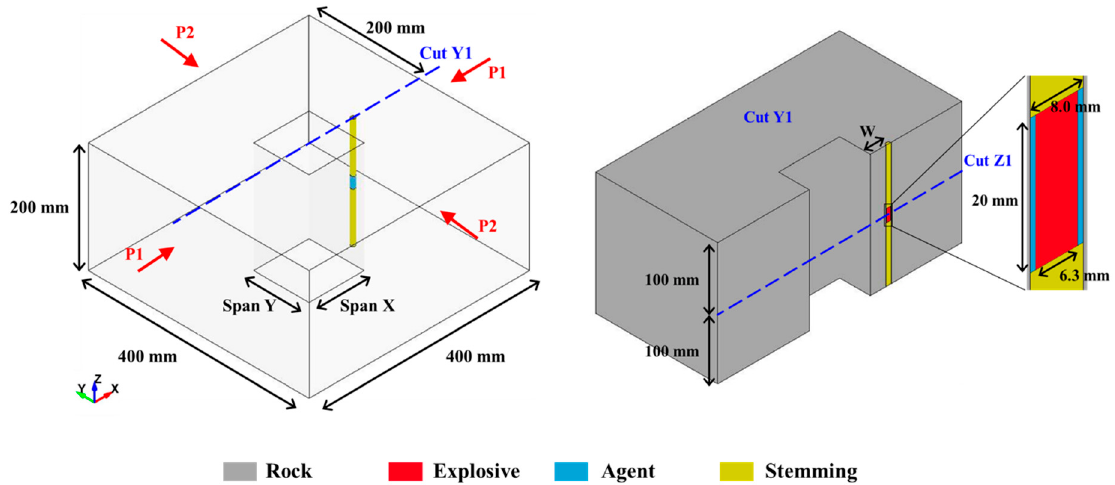
Figure 2. Numerical model of single hole blasting with a lateral free surface.